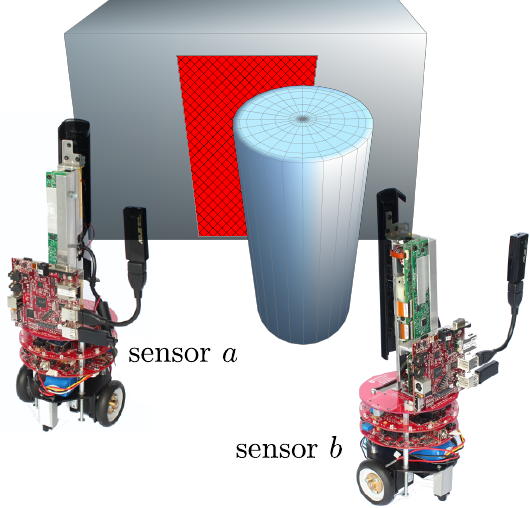
Figure 6. The rectangular surface area at the background is within the field of view of sensor b , but occluded by the cylinder at the